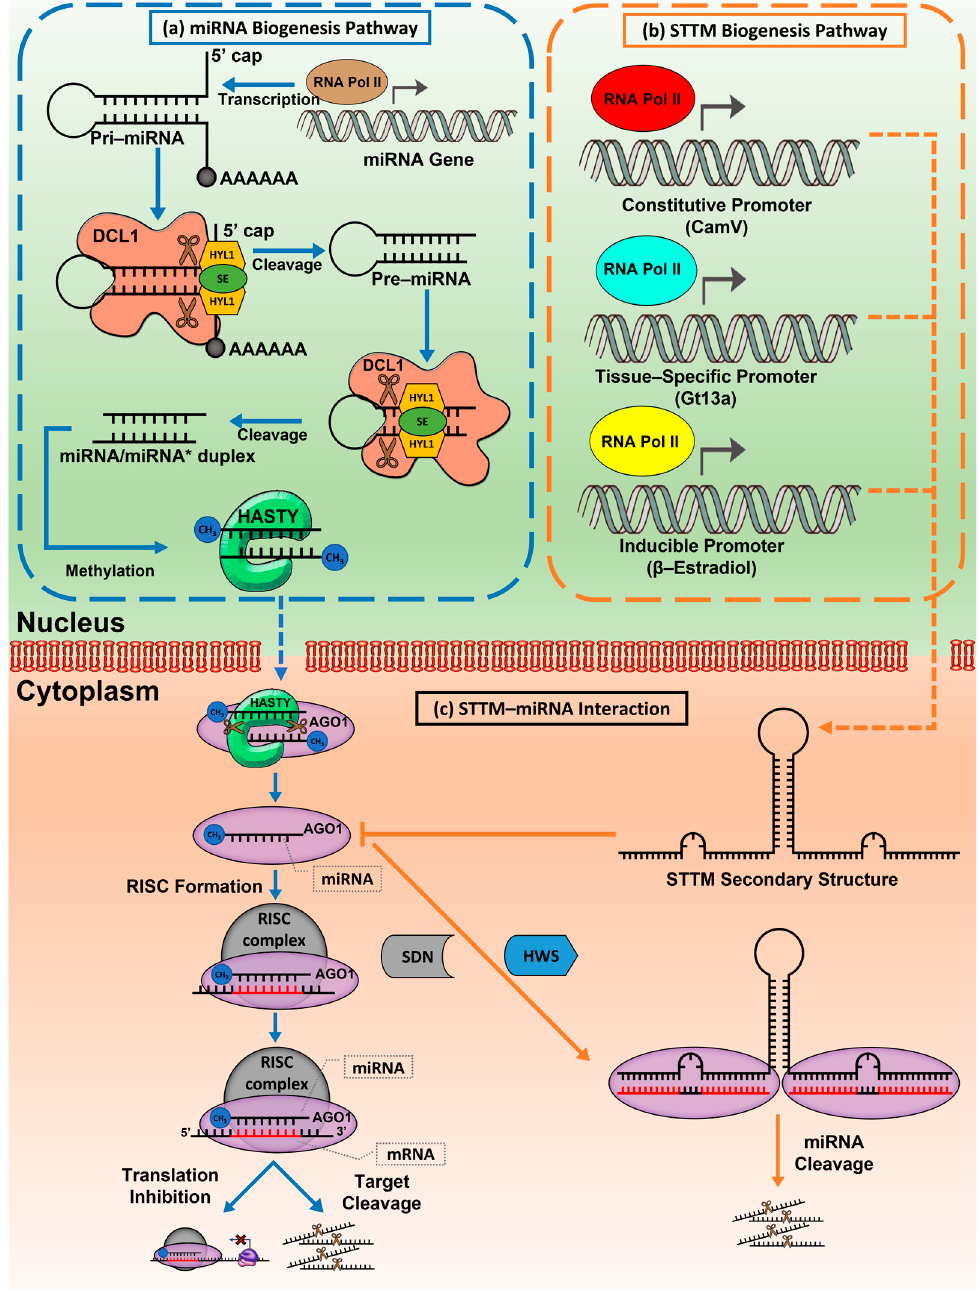
Figure 3. ( a ) miRNA biogenesis and ( b ) STTM expression during different conditions: constitutive expression, tissue-specific expression, and inducible expression in the nucleus while ( c ) in cytoplasm show the degradation process of miRNA–mRNA and the STTM interference in miRNA degradation that also inhibits its activity.